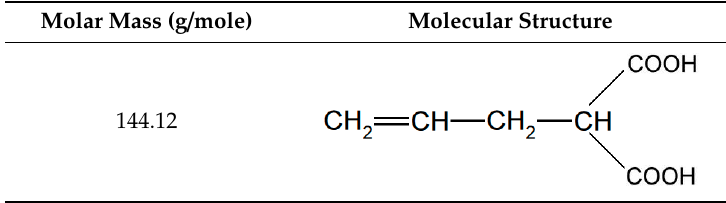
Table 1. Molecular mass and the structure of allylmalonic acid (ALA).